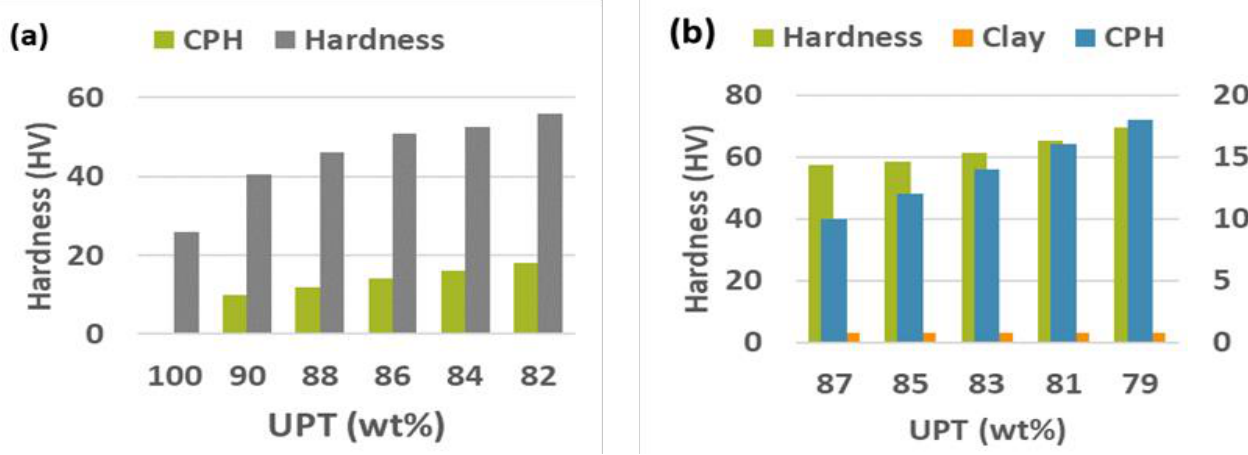
Figure 4. ( a ) Graph of wt% of mono-reinforced and ( b ) hybrid composite against hardness.